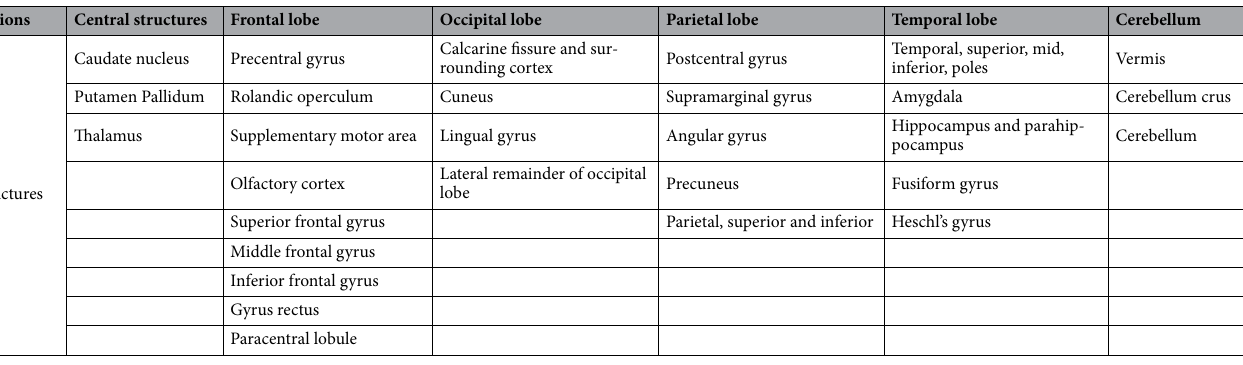
Table 2. The structures included in each brain region.